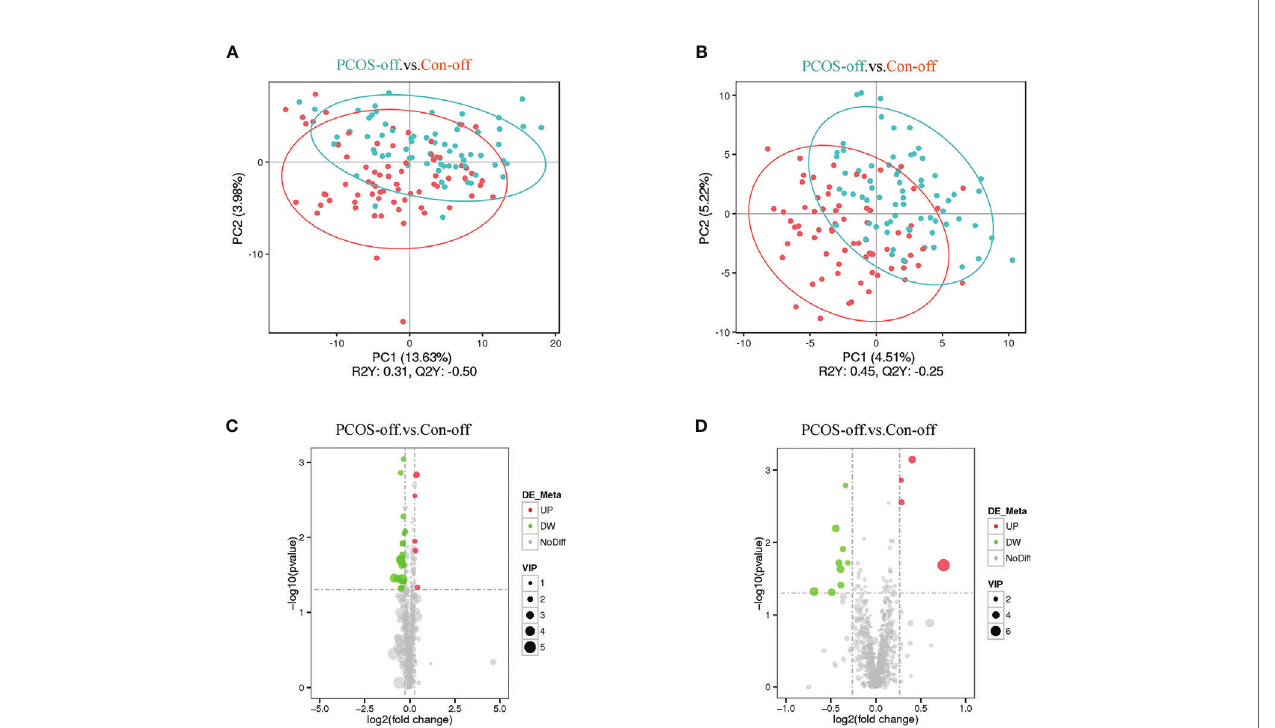
FIGURE 1 | Plasma lipid pro fi les of the general offspring born to PCOS women (n PCOS-off =70) or healthy control women (n Con-off =71). (A, B) PLS-DA scores plot established the relationship model between the metabolite expression and the sample category, which indicated different metabolites pro fi le between PCOS-off and Con-off in the positive (A) and negative (B) polarity modes. (C, D) Volcano plot of p values and fold change between PCOS-off and Con-off summarized the distribution of the differential lipids in the positive (C) and negative (D) polarity modes. P value was calculated using student t tests; VIP value represents variable importance in the projection value from PLS-DA model. Red, green, and gray dots represent metabolites with up-regulation, down-regulation, or no difference between study groups, respectively. PCOS-off, offspring born to PCOS women; Con-off, offspring of the control